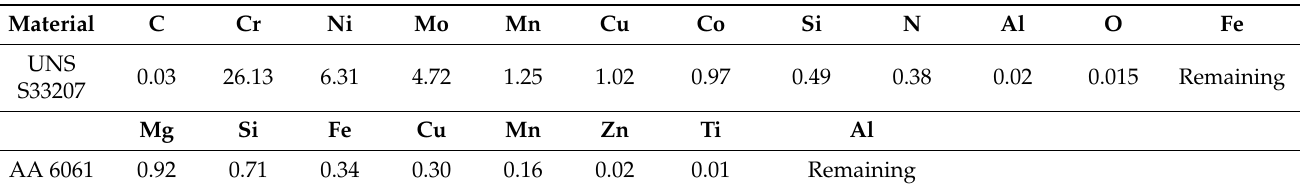
Table 2. Chemical compositions of UNS S33207 and AA 6061, wt.